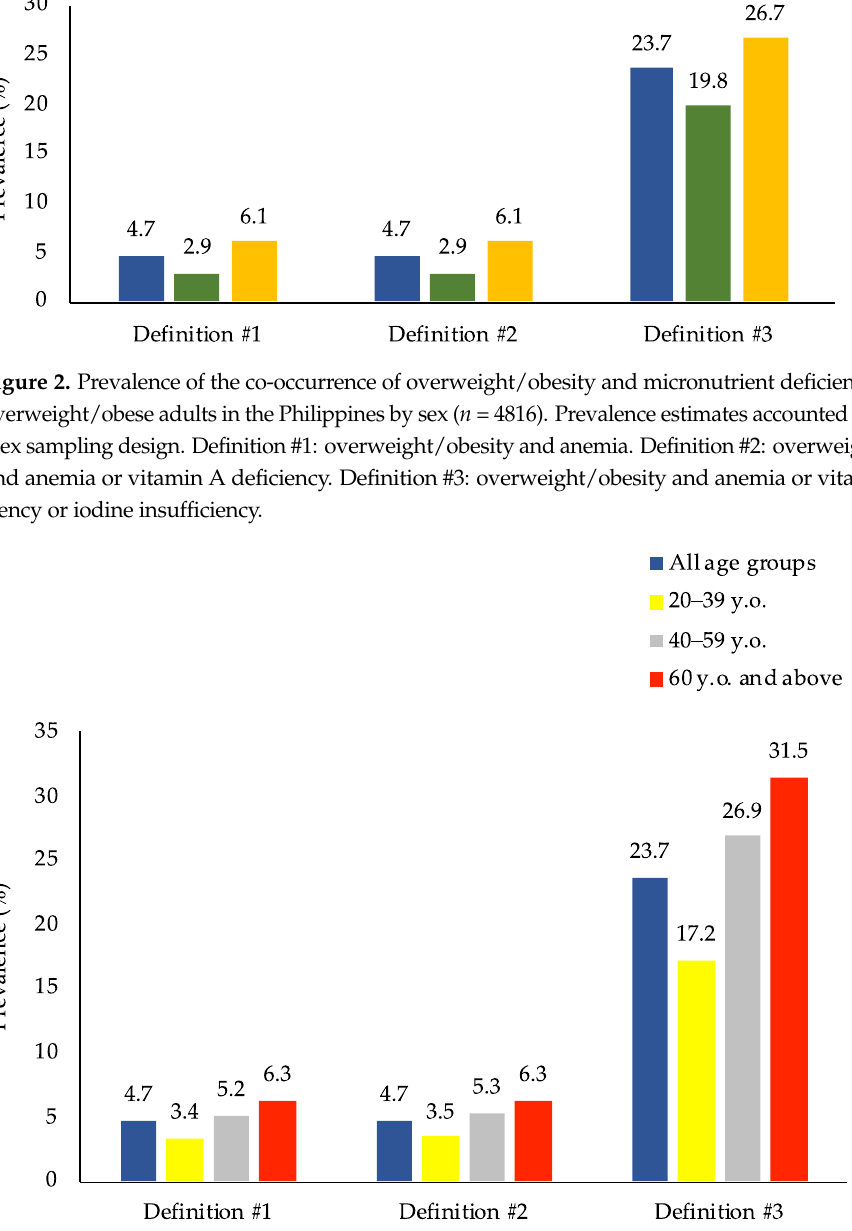
Figure 3. Prevalence of the co-occurrence of overweight/obesity and micronutrient deficiencies among overweight/obese adults in the Philippines by age group ( n = 4816). Prevalence estimates accounted for the complex sampling design. Definition #1: overweight/obesity and anemia. Definition #2: overweight/obesity and anemia or vitamin A deficiency. Definition #3: overweight/obesity and anemia or vitamin A deficiency or iodine insufficiency.